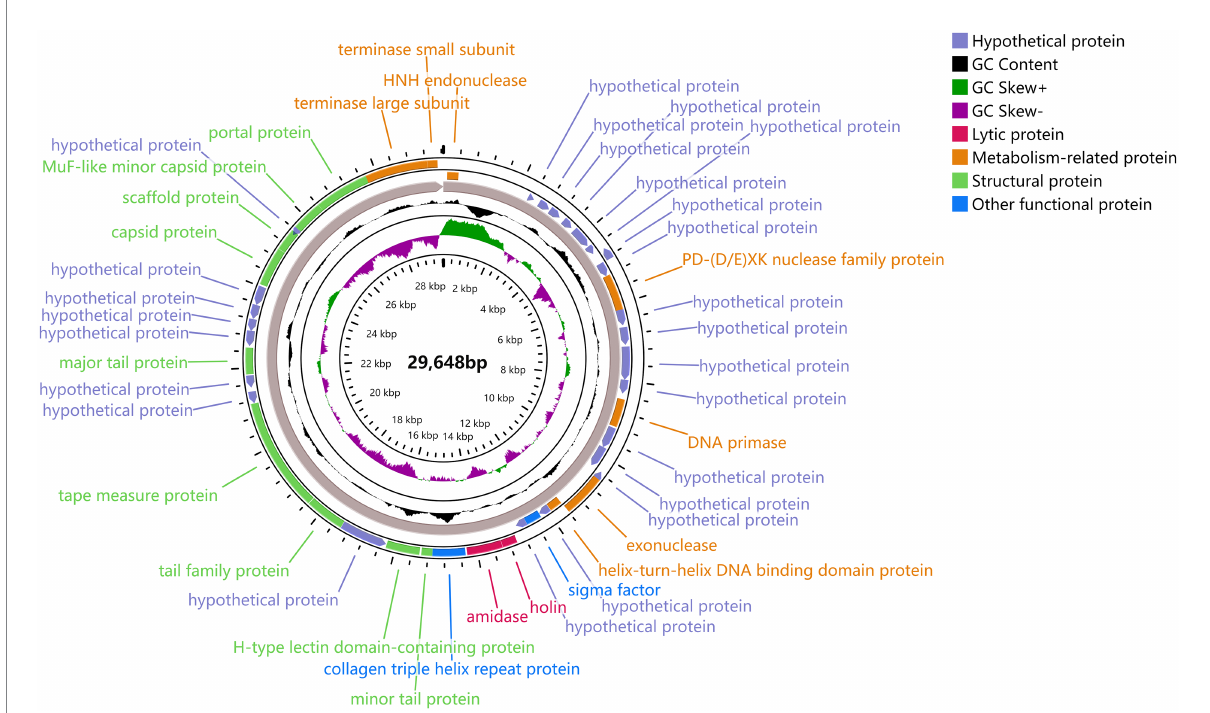
φ PaP11-13 gene visualization. The middle number is the total length of the gene, and the circle diagram can be read from the inside out for G/C content, G/C ratio, transcription direction, and encoded protein. Different colors represent different functions. The outermost circles represent the 45 ORFs encoded by the genome, clockwise for the forward reading frame and counterclockwise for the reverse reading frame.